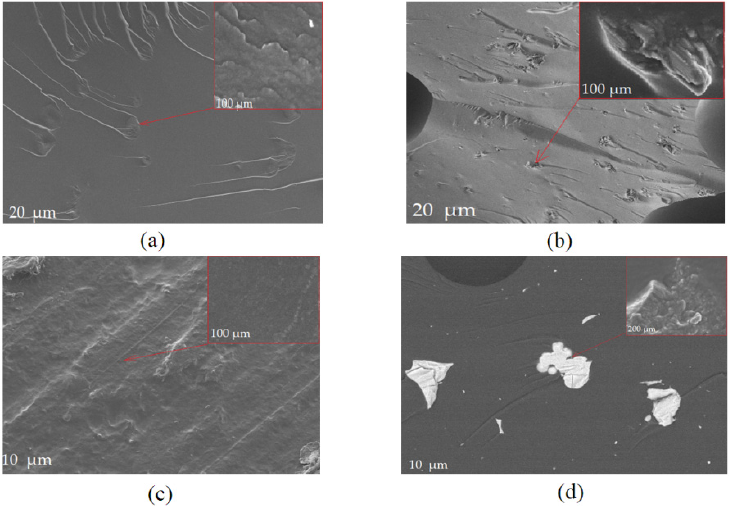
Figure 12. Area SEM pictures of the casein ( a ), starch ( b ), PVA ( c ), and phosphorate gelatin films ( d ), mag. ×1.00, ×25.00 and ×100.00.